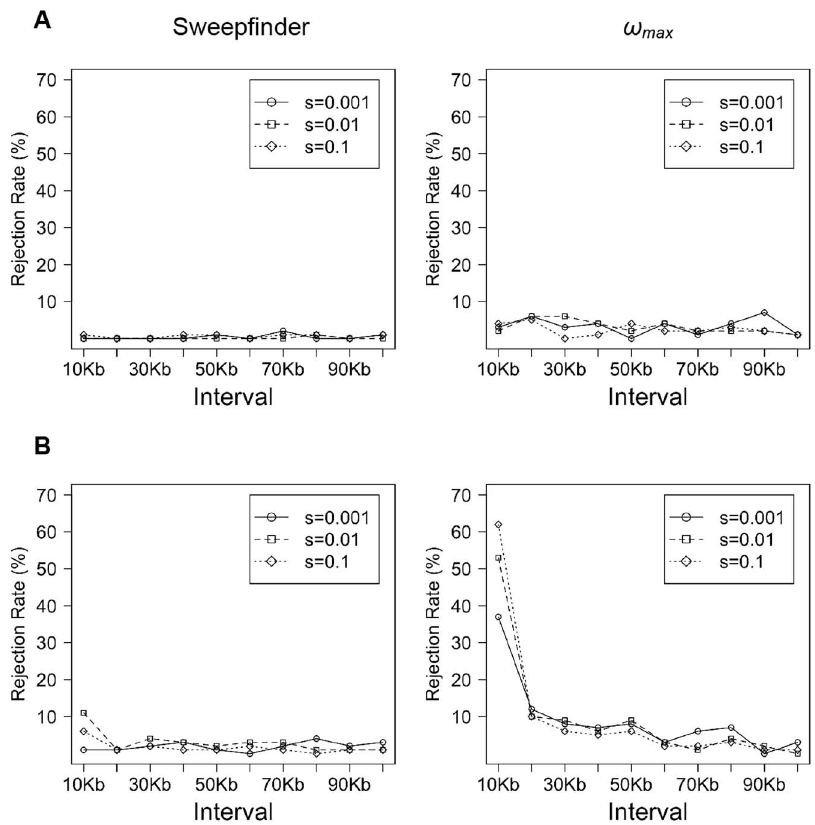
Figure 2. The fraction of simulated replicates rejecting the neutral model by Sweepfinder and v max , with varying population size. The simulations with demographic models mimic the history of (A) Florida beach mice ( N e =2500) and (B) Nebraska Sand Hills mice ( N e =50,000). The time of the bottleneck ( t r =0.1) and time since fixation ( t =0.1) are fixed, but selection strength varies from s =0.001 to 0.1. Ideal performance would be indicated by all replicates showing a significant signal at very small window sizes, suggesting an ability to localize the